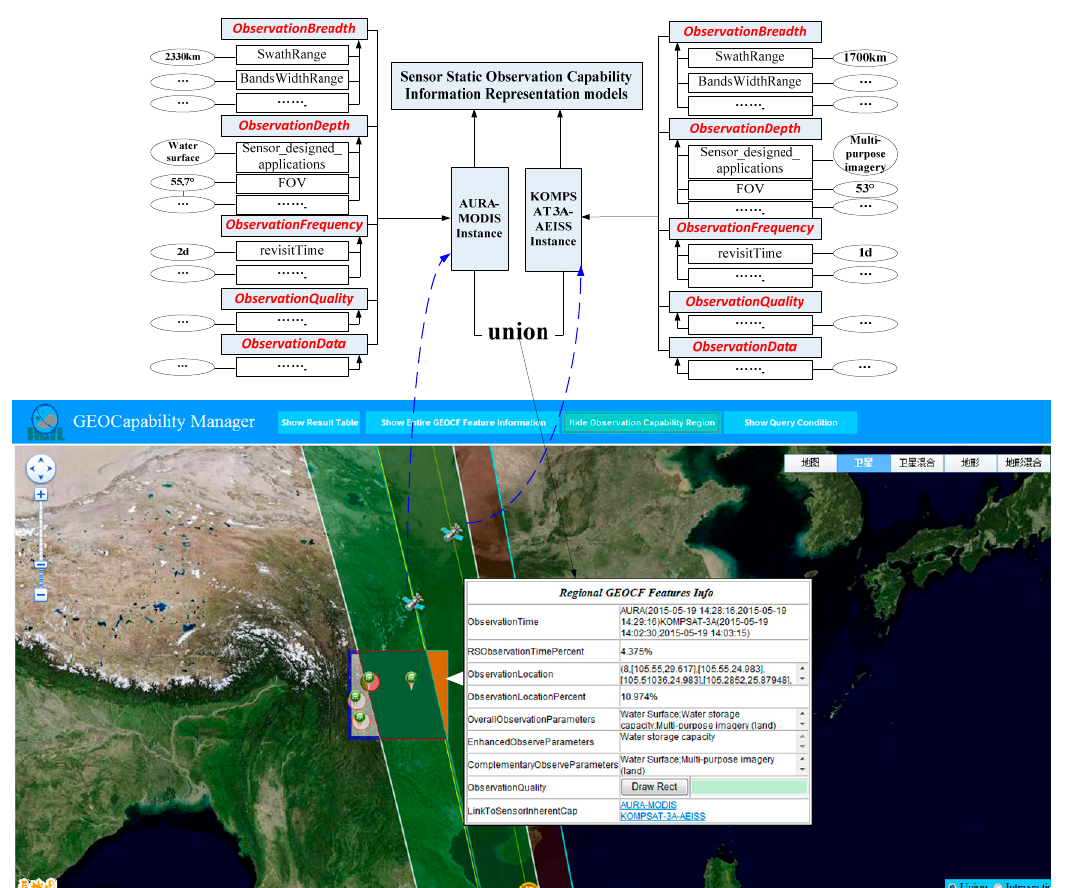
Figure 11. A sample of the sensor–sensor union operation in regional GEOCF modeling. The displayed regional GEOCF feature information refers to the integrated observation capability of the overlapping observation coverage (filled in red) between MODIS-AURA and AIESS-KOMPSAT 3A.